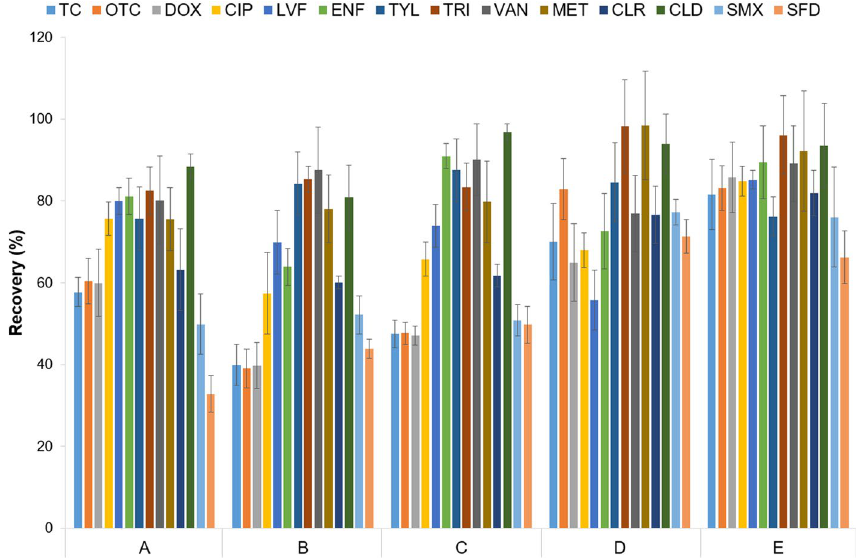
Figure 2. Comparison of SPE conditions ( A ) sample pH = 3; cartridges and eluents: HLB (12 mL methanol) + WAX (5 mL methanol); ( B ) sample pH = 4; cartridges and eluents: HLB (12 mL methanol) +